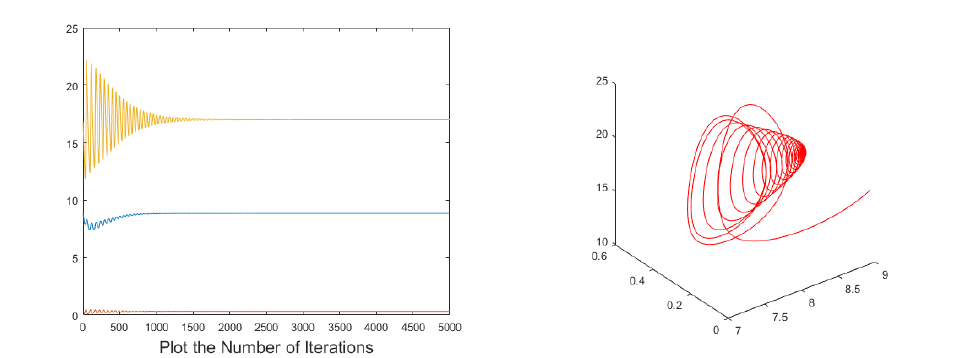
Fig. 10 Left: Locally asymptotically stable trajectories and in Right: the 3D plot of the trajectories of the equilibrium point ( 8 . 84531 , 0 . 315904 , 17 ) where the initial values are taken from the neighbourhood of the origin. For the system D 52 , 41 , 9 [ 13 ] , the eigenvalues are 17 . 3142 + 215 . 992 i , 17 . 3142 − 215 . 992 i , − 95 . 6285 where real part of the eigenvalues are not all negative and hence the equilibrium point ( 3 . 76576 , 0 . 418418 , 41 ) is unstable. The trajectories are shown in Fig.11 with many initial values taken from the neighbourhood of the equilibrium point ( 3 . 76576 , 0 . 418418 , 41 ) .